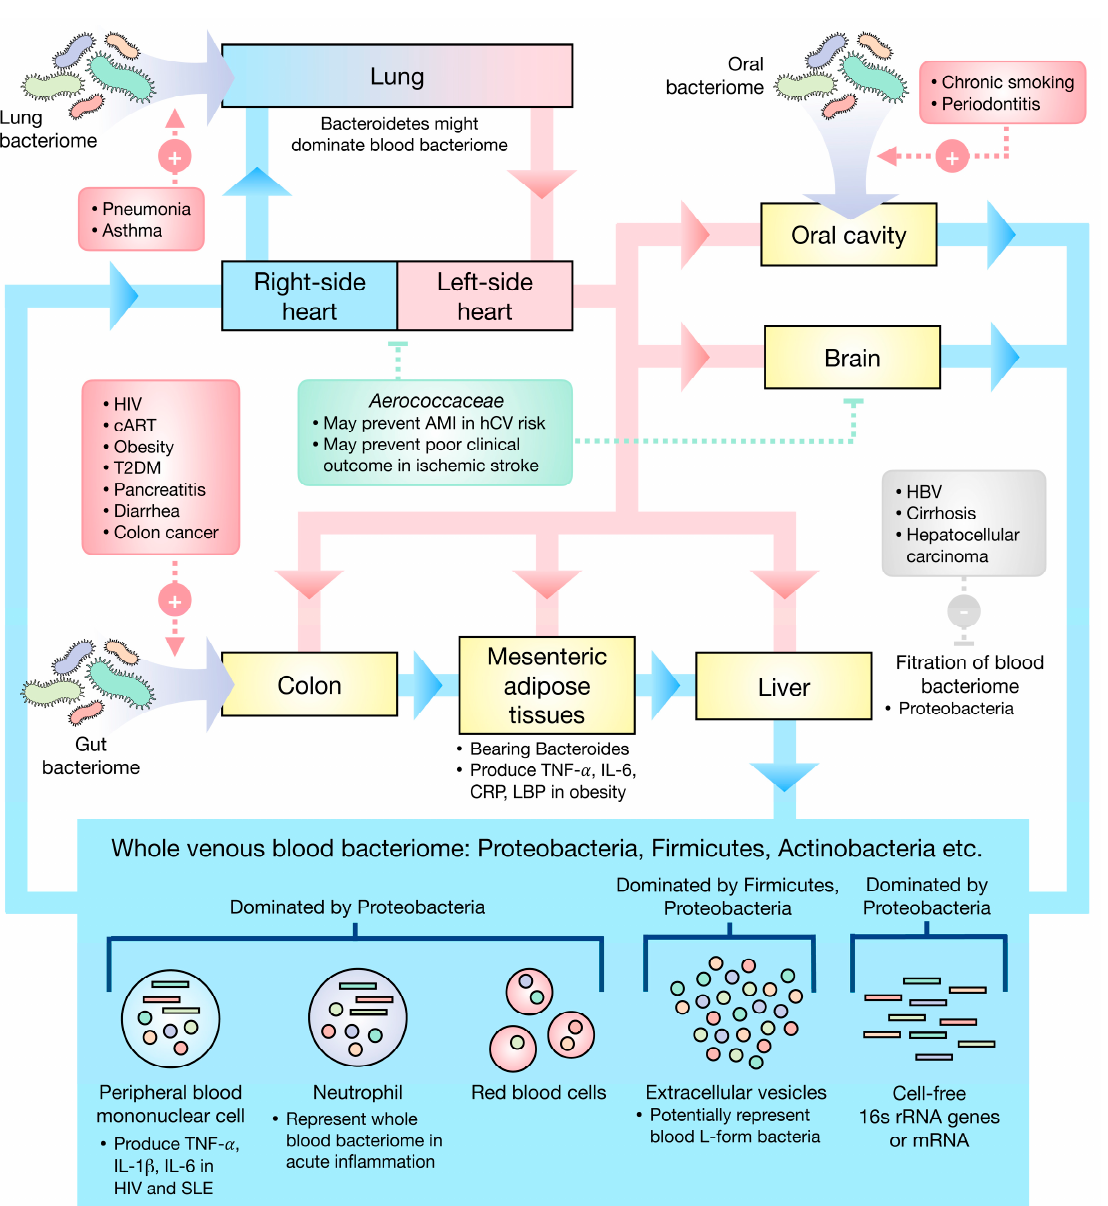
Figure 1. Schematic illustration of the current understanding of the blood bacteriome. ( Red box ) Gut, the colon in particular, oral, and lung bacteriomes may be the primary sources of the blood bacteriome, several factors potentially influencing the translocation of the bacteria. ( Gray box ) The liver could filter the blood bacteriome, especially Proteobacteria, and liver diseases may cause a dete- rioration of this function. ( Green box ) The Cholesterol-degrading Aerococcaceae may play a role in the amelioration of ischemic stroke and prevention of AMI. AMI—acute myocardial infarction, hCV— high cardiovascular risk, HIV—human immunodeficiency virus, cART—combined anti-retroviral therapy, T2DM—type 2 diabetes mellitus, HBV—hepatitis B virus infection, SLE—systemic lupus erythematosus, TNF—tumor necrosis factor, IL—interleukin, CRP—C-reactive protein, LBP—LPS- binding